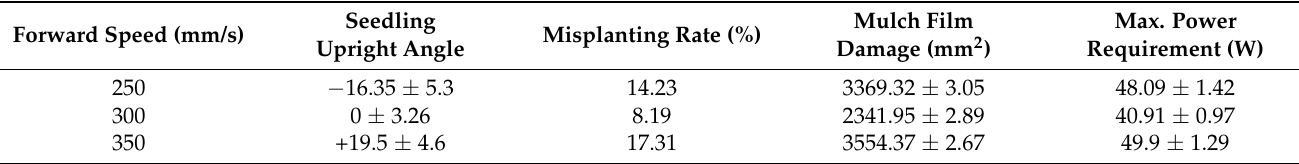
Table 3. Results of field experiments for different forward speed levels of transplanting